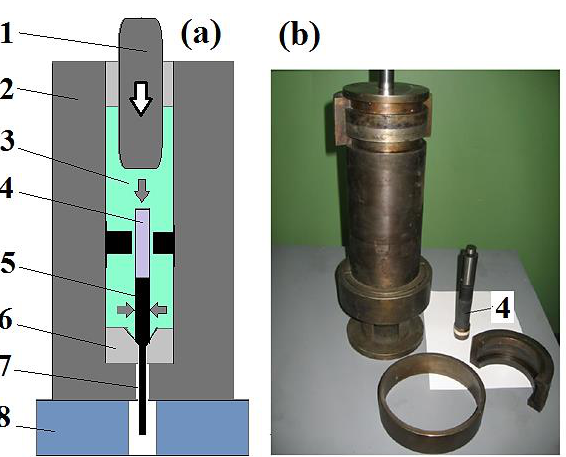
Figure 1. Schematic diagram of plastic deformation of Bi – Sb crystals at high hydrostatic pressure ( a ) and the view of the extruder ( b ). 1—hydrostat plunger, 2—high pressure chamber, 3—working ( a ) and the view of the extruder ( b ). 1 — hydrostat plunger, 2 — high pressure chamber, 3 — working fluid, 4—extruder plunger, 5—Bi–Sb single crystal, 6—die, 7—as extruded polycrystalline TE material, fluid, 4 — extruder plunger, 5 — Bi – Sb single crystal, 6 — die, 7 — as extruded polycrystalline TE ma- 8—lower support terial, 8 — lower support ring.